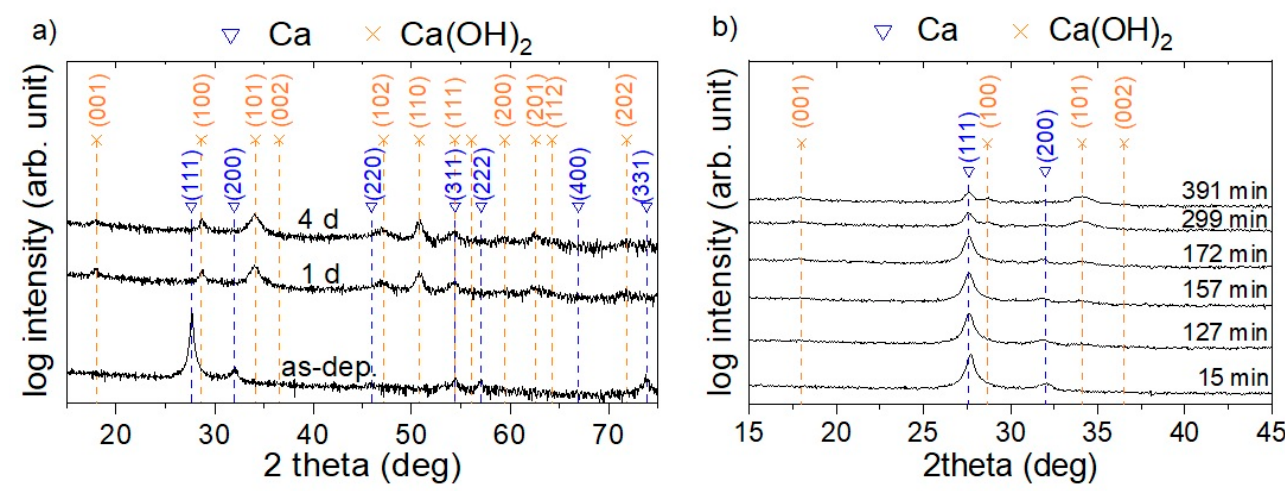
Figure 5. Diffractograms of Ca thin film deposited at 100 °C in ( a ) as-deposited state ( ≤ 3 min atmosphere exposure) and after 1 and 4 days of atmosphere exposure obtained using Bragg–Brentano (2° offset) scans and ( b ) for varying atmosphere exposure times using a large area detector.